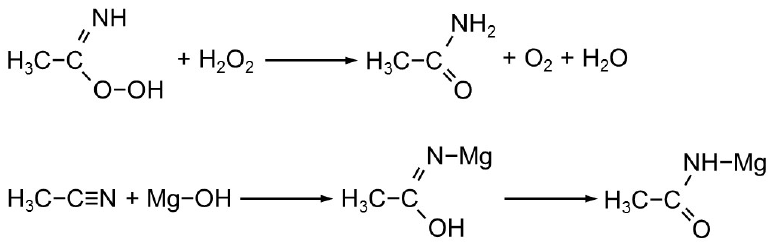
Figure 11. Paths of an acetamide-like species formation alternative to the Baeyer – Villiger